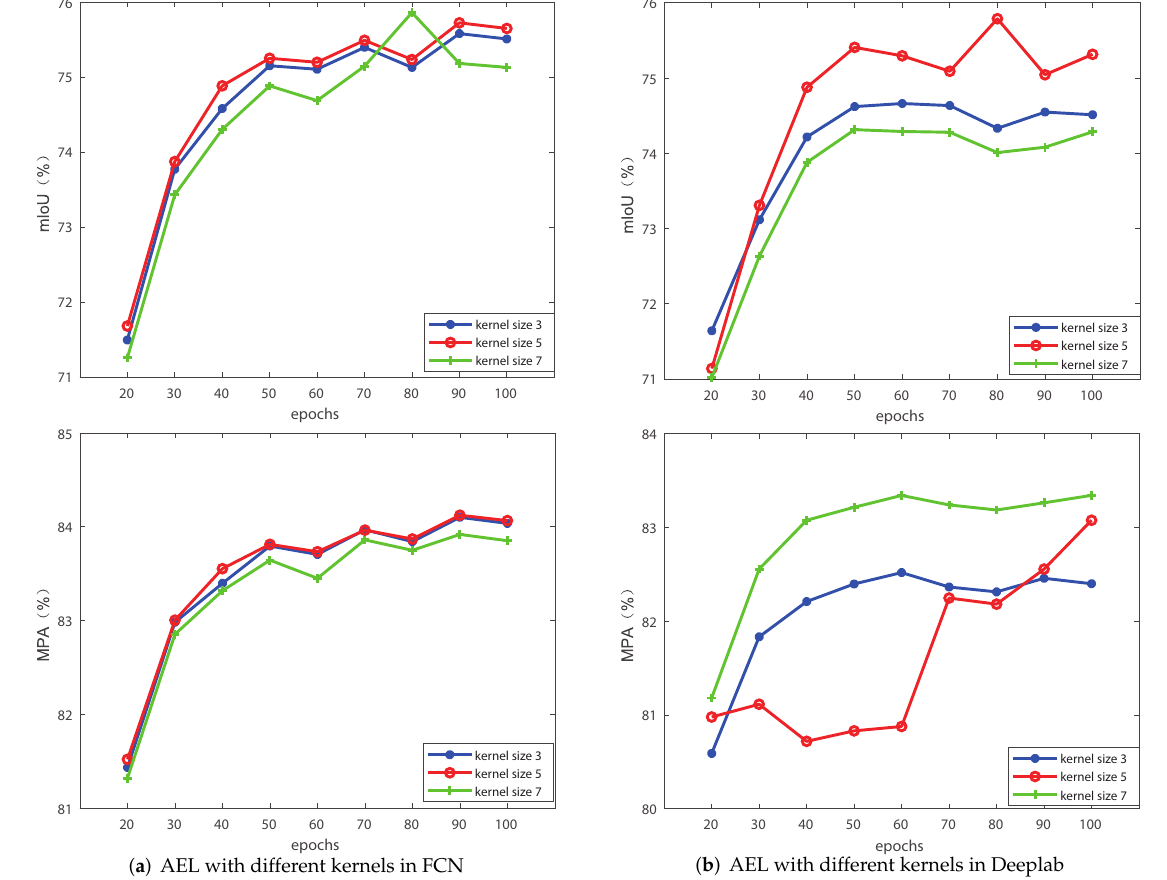
Figure 6. Comparison of different kernels of Adaptive Edge loss on Potsdam dataset. ( a ) The baseline is FCN. ( b ) The baseline is Deeplabv3. The metrics are mIoU and